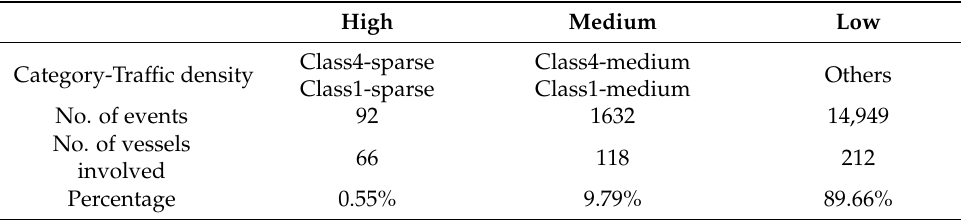
Table 5. Classify suspicion level for Brest, France validation dataset.